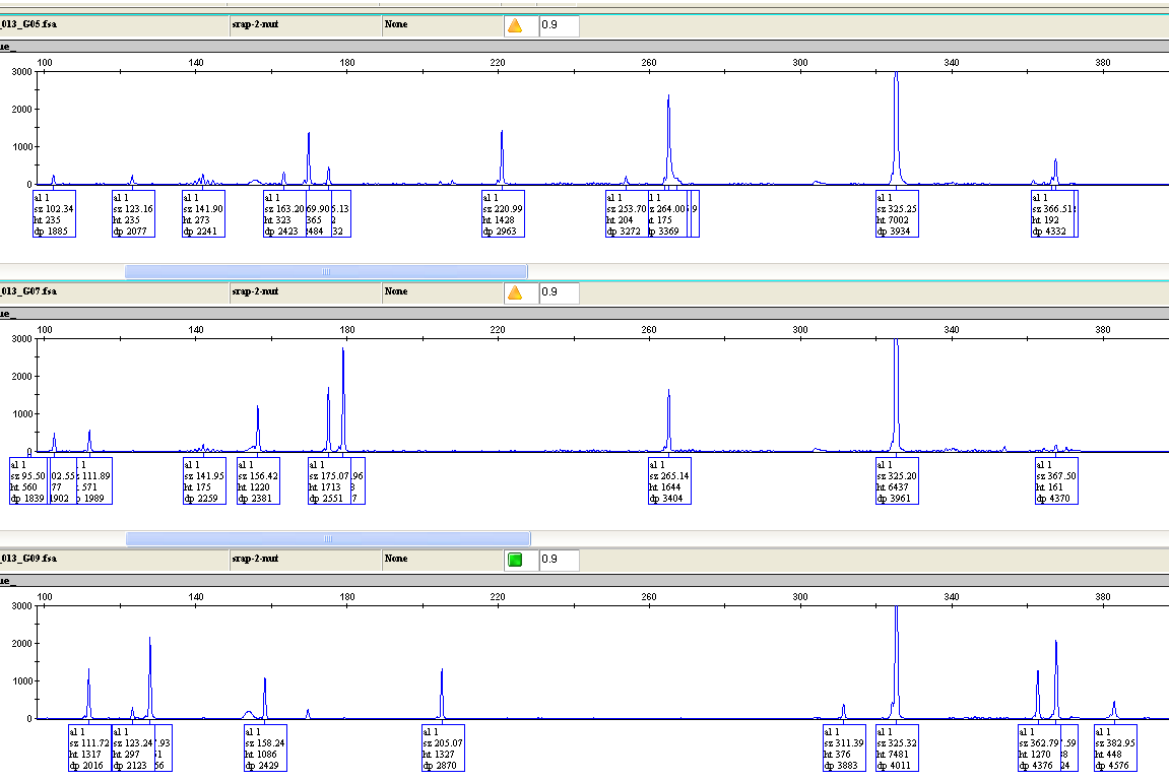
Figure 1. SRAP markers electropherograms of six lentil genotypes using ME2/EM2 primer combination analyzed in the GeneMapper software (Applied Biosystems, Foster City, CA,